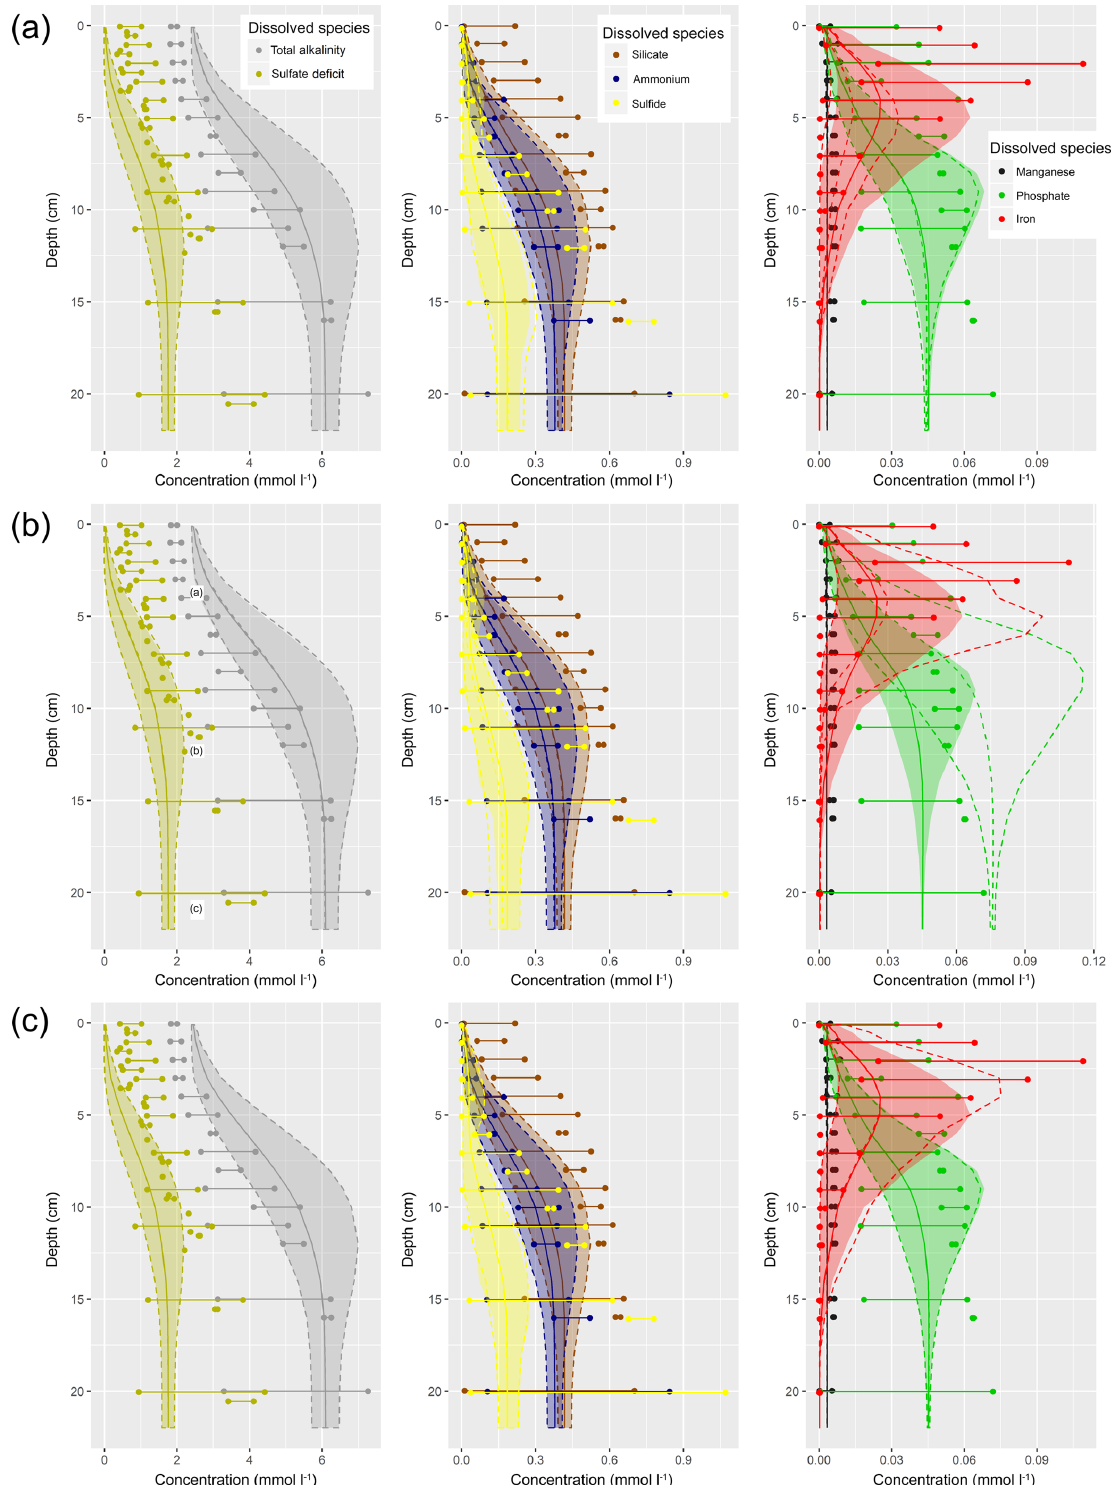
Figure C1. Pore water concentrations of several dissolved species at the silt station Tromper Wiek. Points and horizontal lines indicate the range of measurements. Solid curves and shading present the model results and indicate year-average concentrations and the seasonal range. Dashed curves show the same, but for a model version which neglects one of our improvements: (a) without correcting the diffusivity of total alkalinity for hydroxide ions; (b) without correcting the solute concentrations by activity coefficients; (c) without assuming adsorption to clay